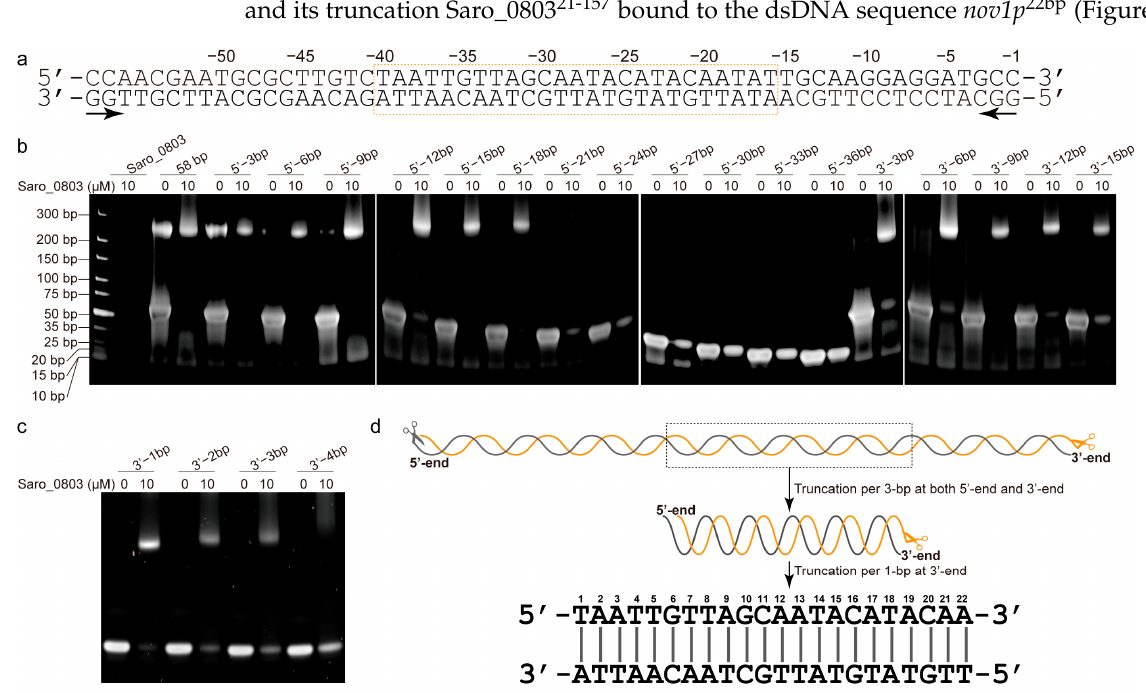
Figure 2. Identification of a 22 bp core binding sequence of nov1 promoter with Saro_0803. ( a ) The double-stranded oligonucleotide sequence with a 58 bp truncation of the nov1 promoter. The bilateral arrow below the sequence indicates the two opposite directions of the serial 3 bp truncations. The box in orange indicates the 25 bp middle section (pos. from − 16 to − 34) of the nov1 promoter, which is speculated to be the truncation with a critical length that retains Saro_0803 binding ability. ( b ) EMSA analysis of the binding site of Saro_0803. The concentration of Saro_0803 with 0 µM or 10 µM incubated with 5.0 µM truncated dsDNA fragments of nov1 promoter with serial lengths. ( c ) EMSA analysis indicating the binding site of Saro_0803 on nov1 promoter by deletion from 3 ′ -end of the 25 bp middle section. The concentration of Saro_0803 is labeled in the same manner as in ( b ). ( d ) The illustration of the core sequence of nov1p 22bp revealed by the repeated truncation performed on the original 58 bp truncation of the nov1 promoter.